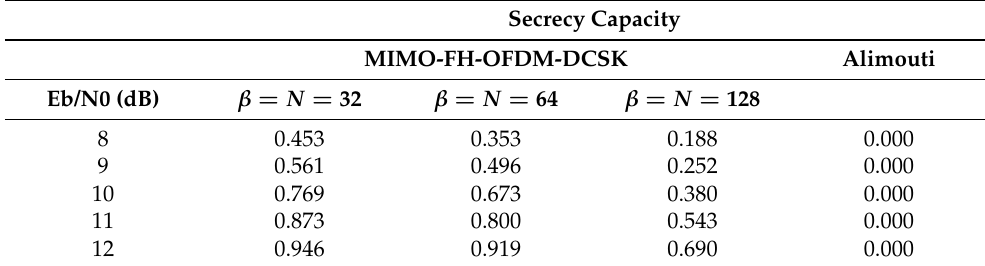
Table 2. Secrecy capacity comparison between the proposed system and the benchmark scheme (STBC) in the Rayleigh